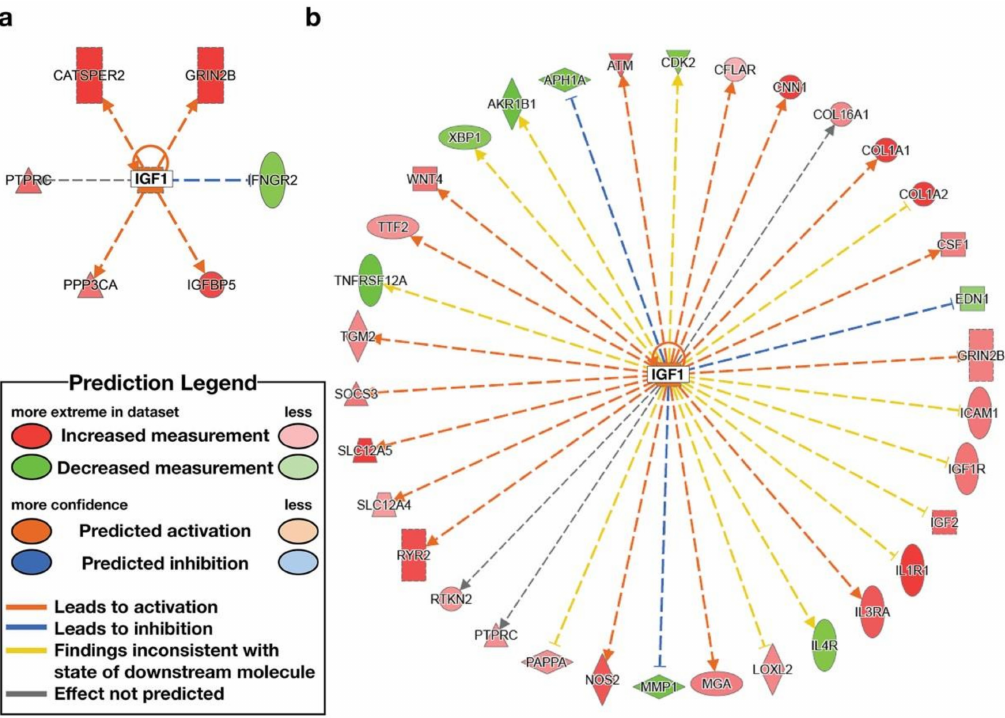
Figure 9. Differentially expressed genes (FDR adjusted p -value < 0.05) contributing to the identifica- tion of upstream regulator, Insulin like growth factor 1 (IGF1) following lignan flaxseed intervention: ( a ) predicted activation of IGF1 in high-ENL excreters (z-score 2.172); ( b ) no statistically significant effect in low-ENL excreters (z-score